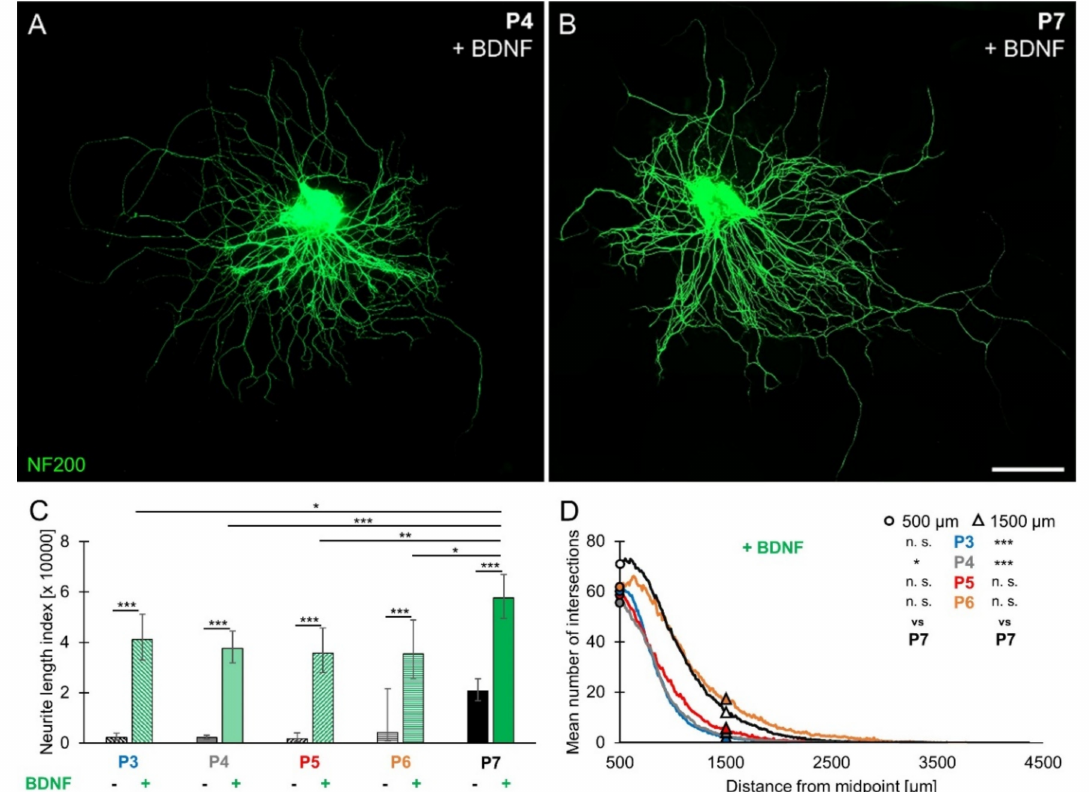
Figure 2. Brain-derived neurotrophic factor (BDNF)-stimulated neurite outgrowth in spiral ganglion explants from P3 to P7 mouse cochlea. P3–P7 SGEs were cultured in medium supplemented with 25 ng / mL BDNF (1.85 nM). After 4 DIV, SGEs were fixed and stained for NF200. Neurite outgrowth was quantified and the number of extending neurites was determined. ( A,B ) Images of NF200-immunolabeled (green) P4 ( A ) and P7 ( B ) SGEs are shown. Scale bar ( A,B ): 500 µ m. ( C ) Neurite outgrowth was quantified. BDNF-stimulated neurite outgrowth was statistically compared